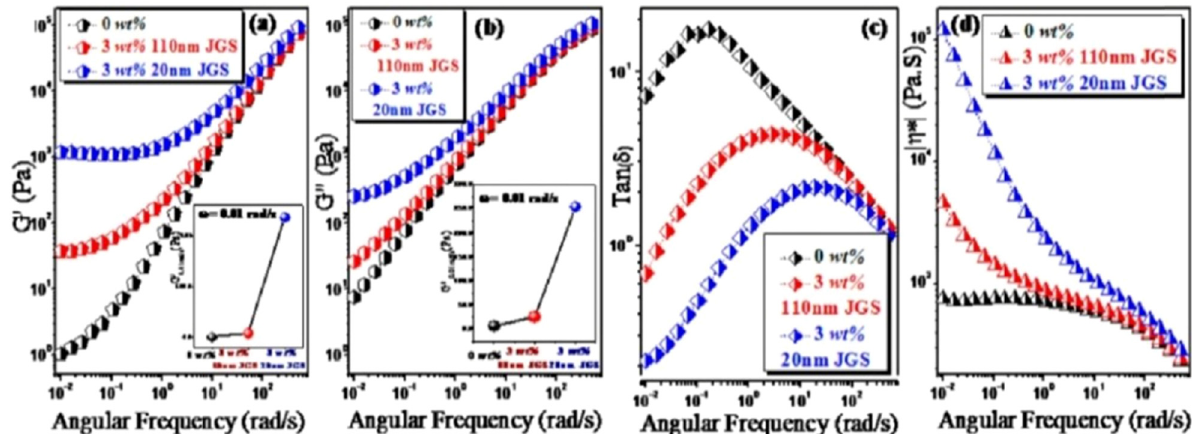
Figure 19: Rheological properties of PVDF/PLLA blends fi lled with two nano - sized JGS ( 20 nm/110 nm ) : ( a ) G ′ , ( b ) G ″ , ( c ) tan δ , and ( d ) | η * | [ 123 ] ; Copyright: 2017 with permission from ACS.